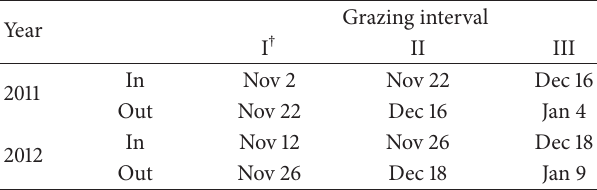
Table 1: Sequence and schedule for winter